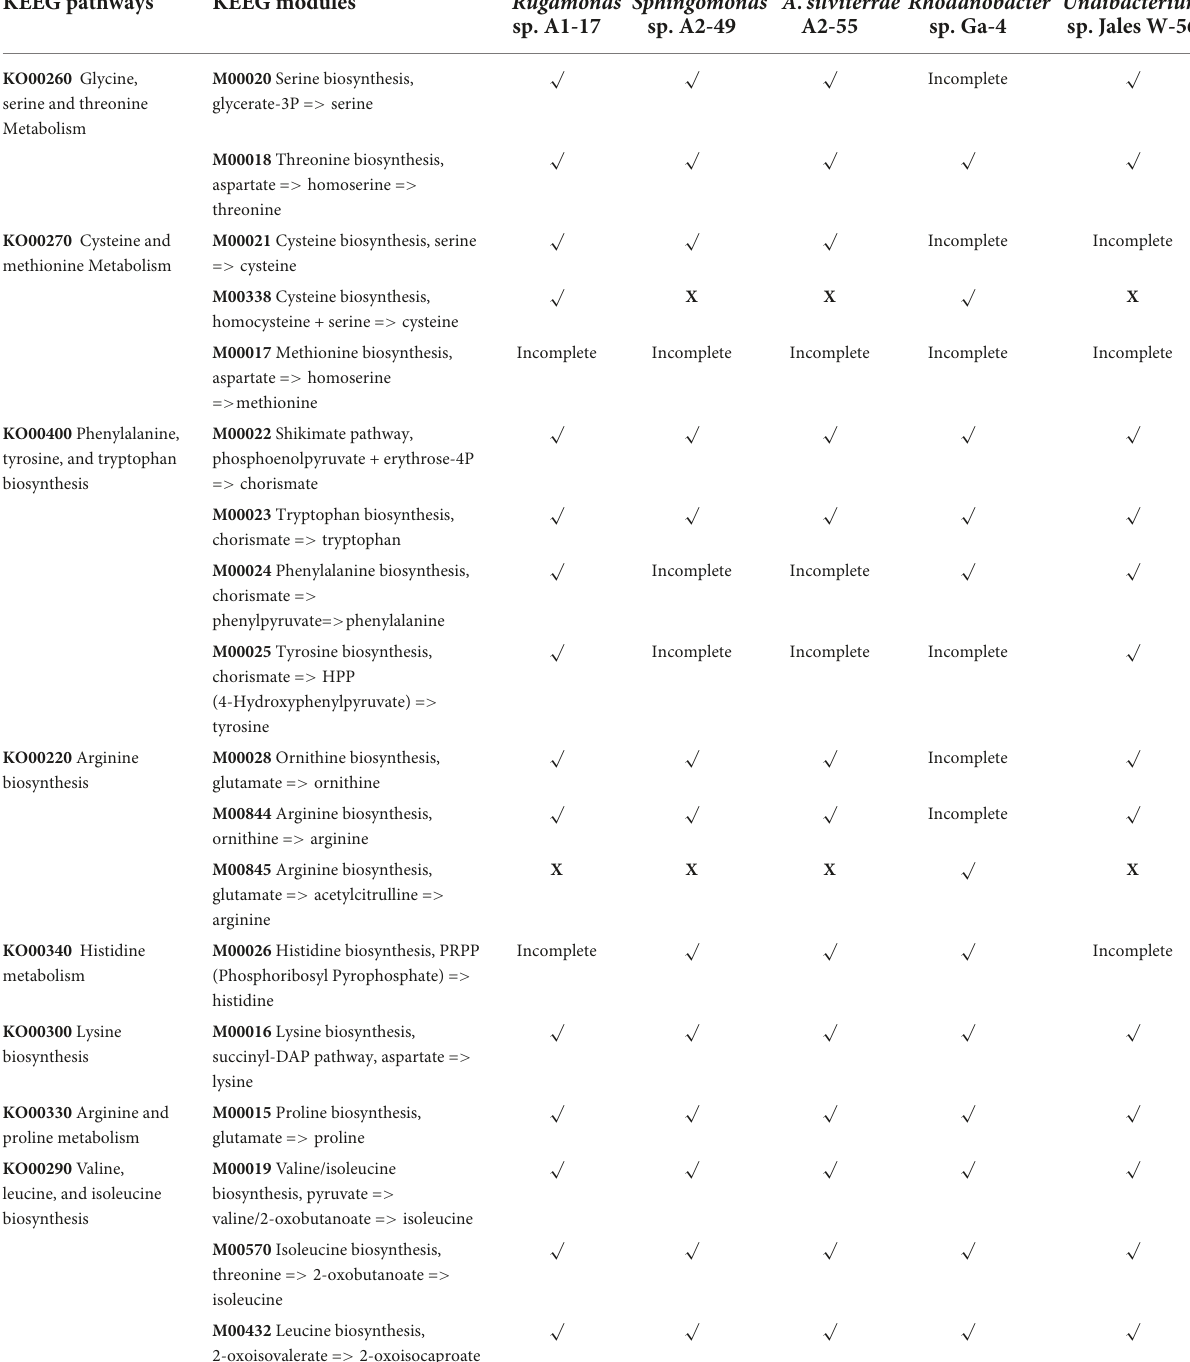
TABLE 2 KEEG pathways and modules for amino acids biosynthesis and metabolism determined by KAAS (KEGG Automatic Annotation